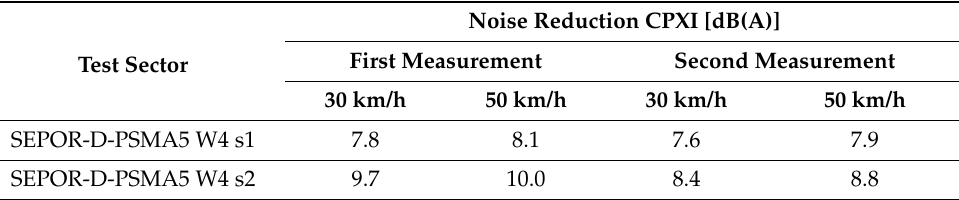
Table 8. Noise reduction of poroelastic mixture placed at the D ˛abr ó wka long test